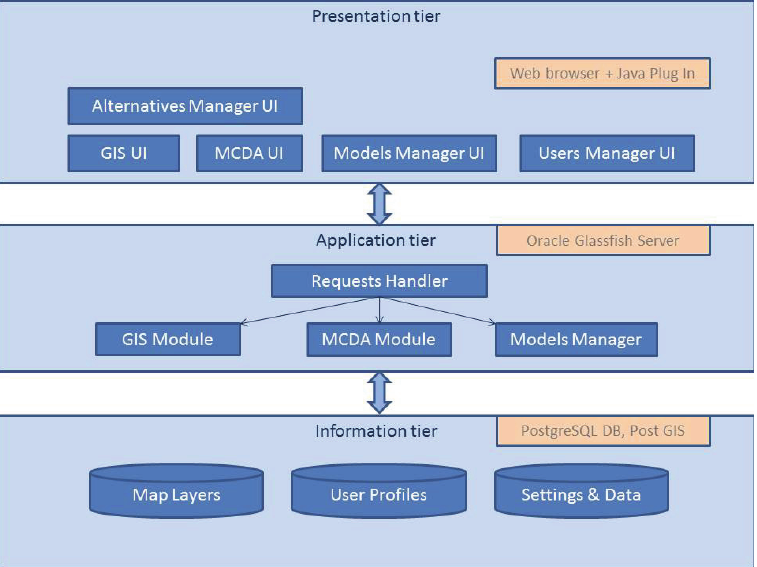
Fig.2. A generalized scheme of the Decerns